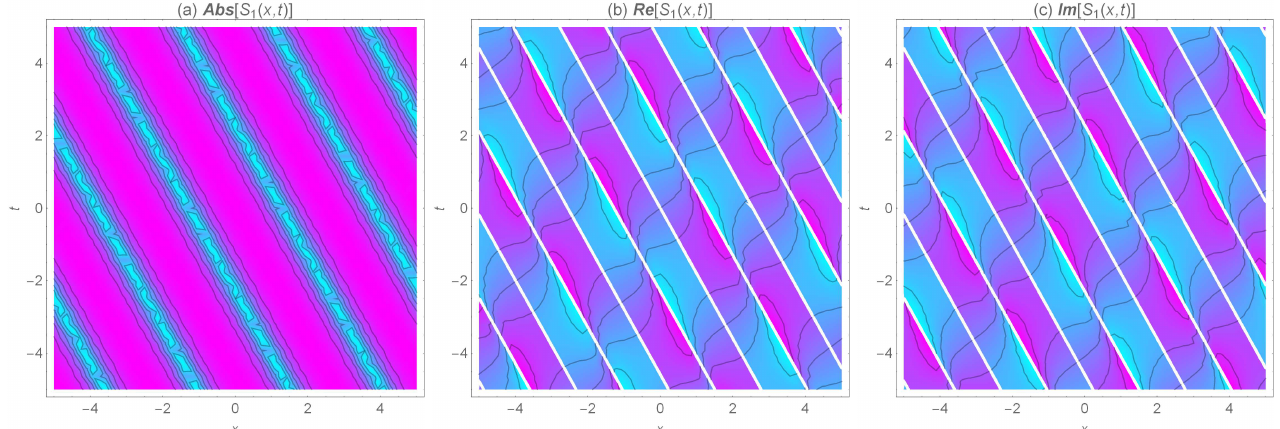
Figure 4. The 2D density of the wave surfaces for the absolute, real, and imaginary values of the periodic soliton solution for b = 0.9, 4 c = − 0.3, s = 1.5, k = 1, ϑ 0 = 0.2, ε 1 = 1, ε 2 = 1, ε 3 = 1.2, Ω = 0.5.